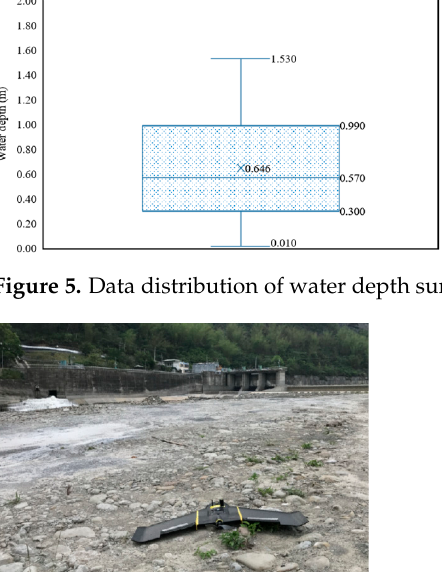
Figure 6. SenseFly Ebee+ was used in this study. The picture taken before the flight mission on 10 April 2017.